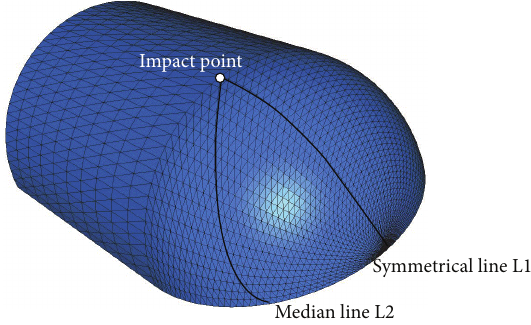
F 3: CAD of complex part.